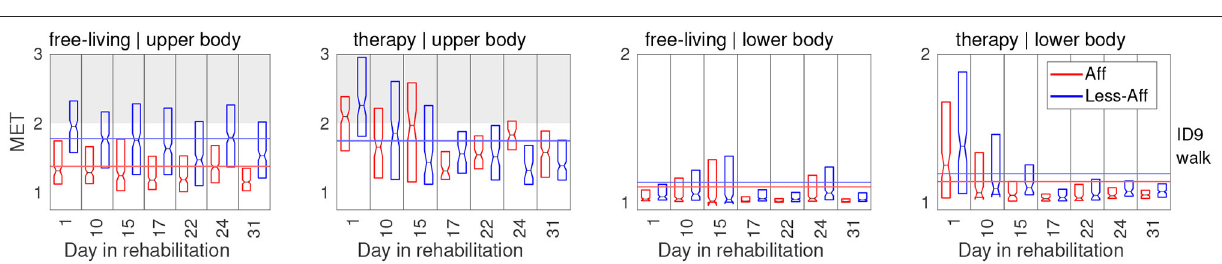
FIGURE 6 | PA in MET equivalents for affected and less-affected upper and lower body for patient ID9. To optimize readability, first and third quartile are shown. Notches represent median MET equivalent